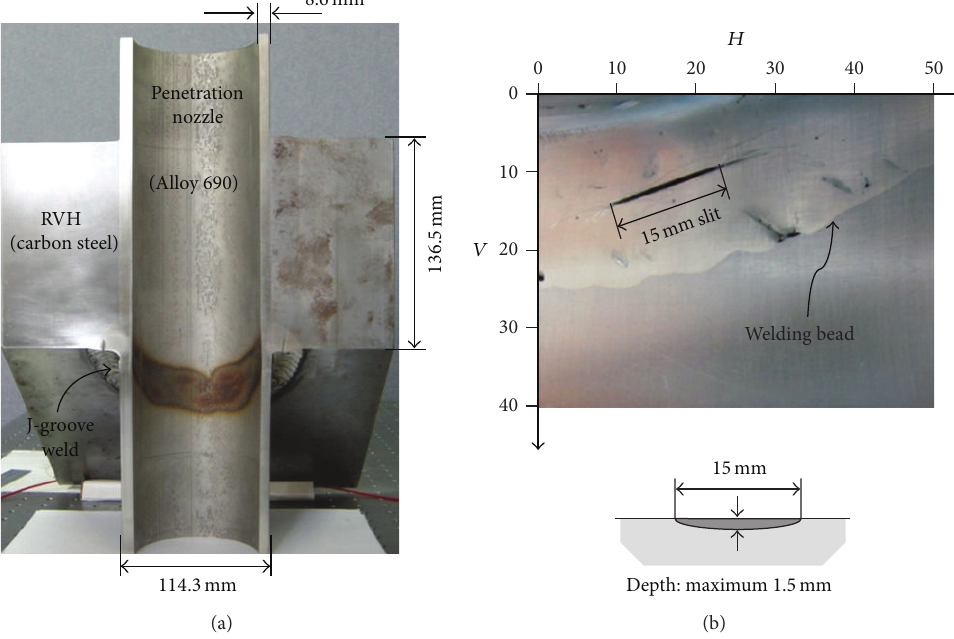
Figure 4: (a) Full-scale mockup of the CRDM assembly and (b) the artificial crack on the dissimilar welding bead.